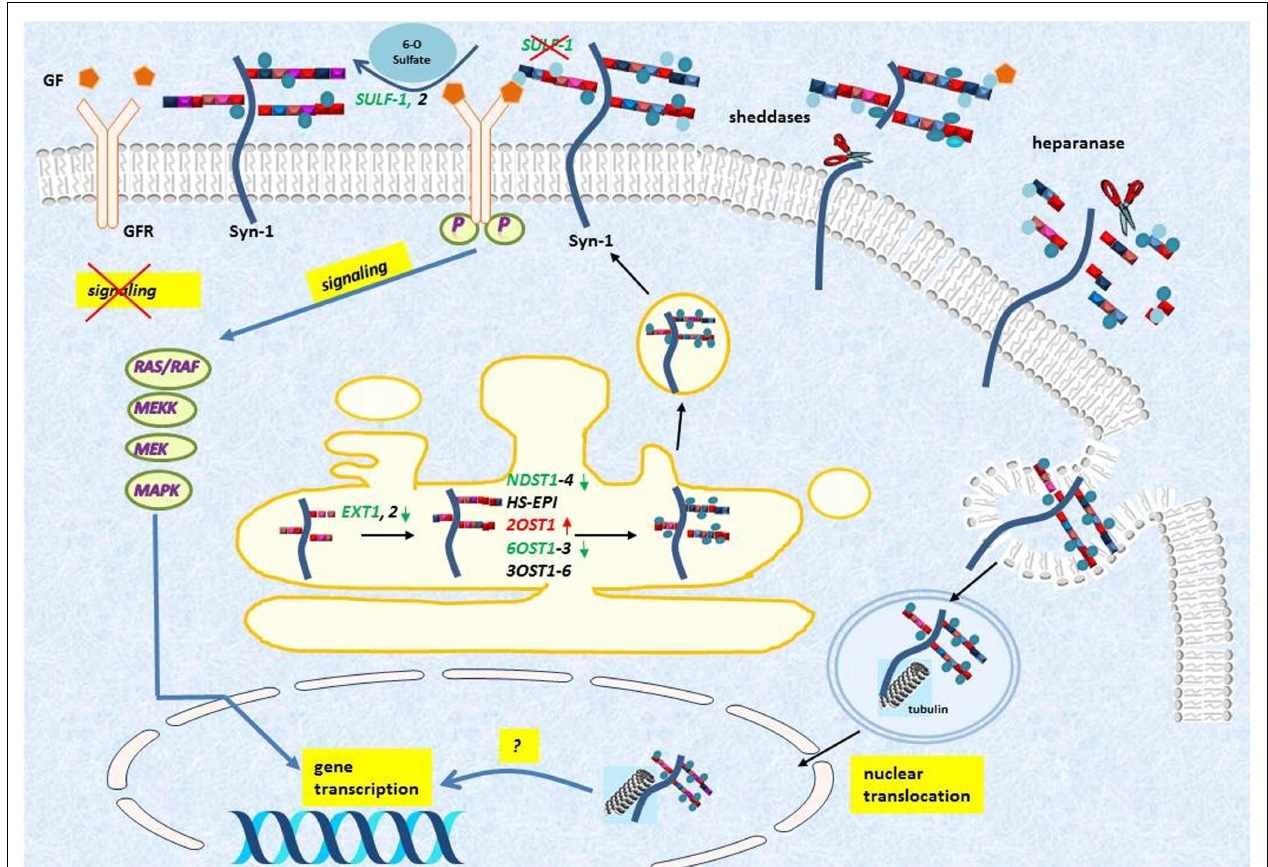
function of this translocation is still incompletely understood. Upon syndecan-1 overexpression, several biosynthetic enzymes are modified including, EXT, exostosin; NDST, N -deacetylase/ N -sulfotransferase; OST, O -sulfotransferase; HS-EPI, C5 epimerase; and they collectively lead to altered HS synthesis and sulfation pattern (Colors represent: red = upregulated and green = downregulated).The endosulfatase SULF-1, specifically removes the 6- O -sulfate groups from the HS chains, and thereby may inhibit growth factor signaling. Downregulation of SULF-1 by syndecan-1, detected at transcriptional level, may lead to modulation of downstream growth factor